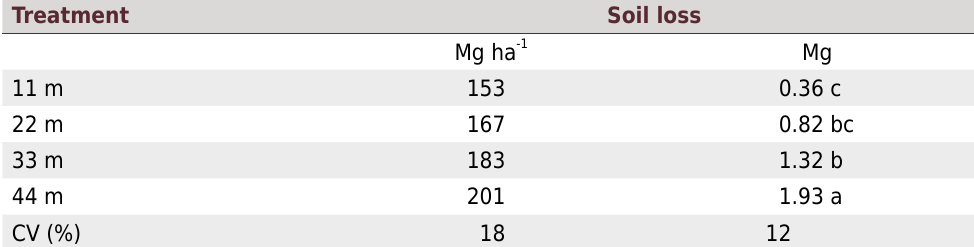
Means values followed by different letters in the column differ statistically from each other by the Tukey test (p≤0.05).